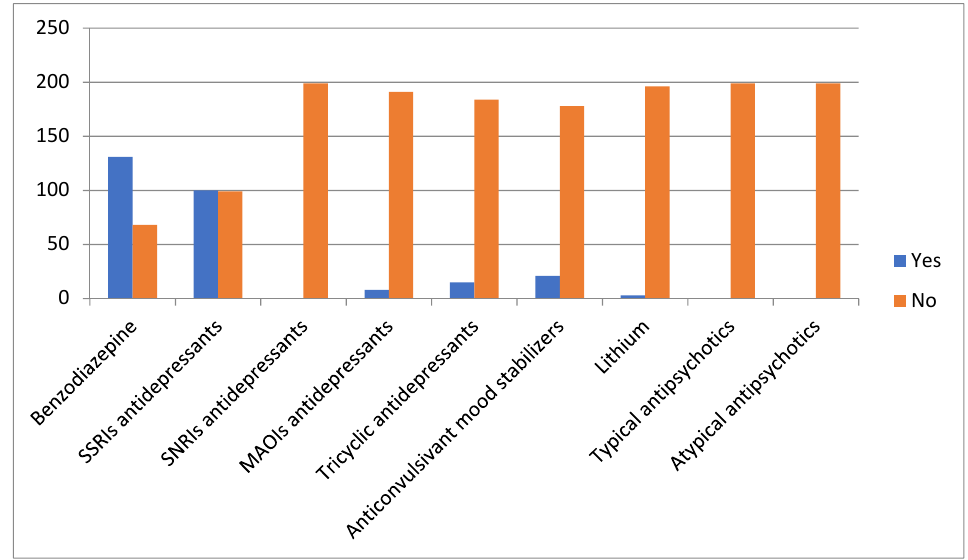
Figure 1. Type of psychopharmacological treatments among pregnant women with pharmacologically treated depressive disorders (DG-Tr, n = 199). SSRIs: selective serotonin reuptake inhibitors; SNRI: serotonin-norepinephrine selective reuptake inhibitors; MAOIs: monoamine oxidase inhibitors. Table 3. Linear regression analysis of clinical variables potentially affecting the APGAR score 5 min A linear regression model was developed, setting the APGAR score at 5 min after birth as the dependent variable; the independent variables were age, smoking habit, after pharmacological treatment, cesarean section, neonatal weight and preterm birth. The linear regression analysis (Table 3) showed a significant linear association between APGAR scores and neonatal weight, but not between APGAR scores and pharmacological treatment.